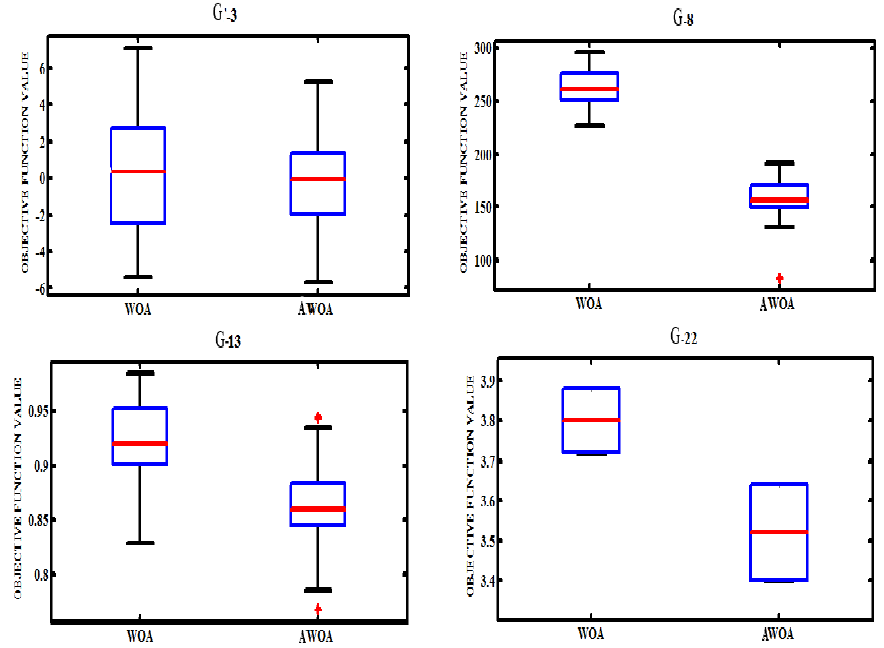
Figure 8. Boxplots for Distribution of Objective Function Values.